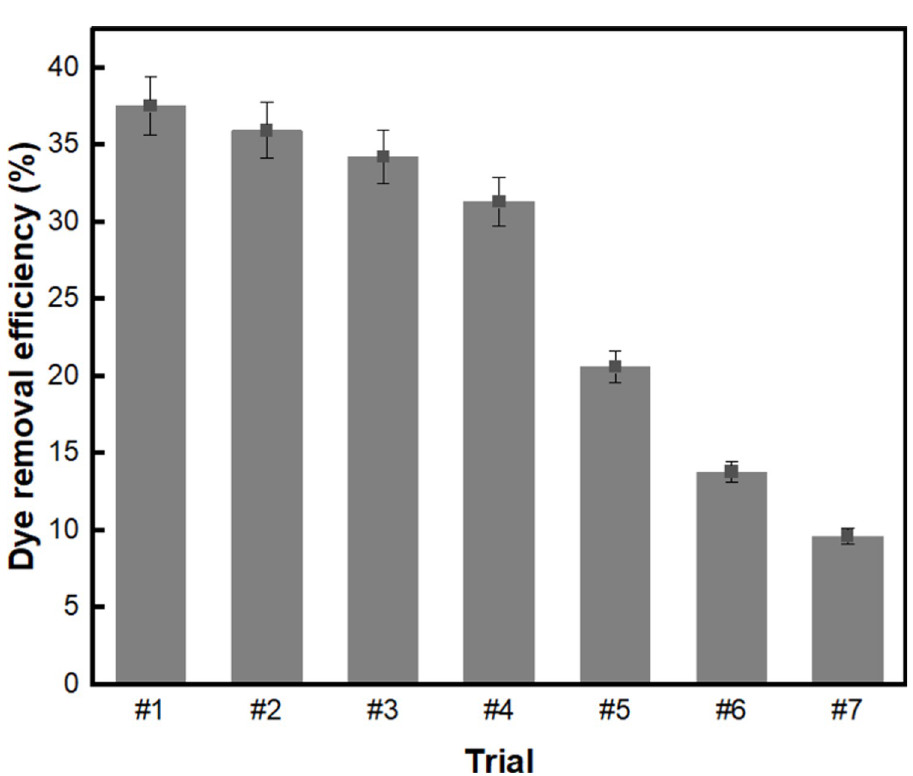
Fig 12. Dye adsorption rate (%) of BC-COF bio-leather with repeated dye adsorption trials (Extraction conditions: Liquor ratio of 1:10 (w/v), coffee at an amount of 200 wt% BC, 90˚C, 1 h; dyeing conditions: Fabric-to- liquor ratio of 1:10 (w/v), 70˚C, 30 min, meta-mordanting with 1% of FeSO 4 ; dye adsorption conditions: 50 mg/L of methylene blue solution with a fabric-to-liquor ratio of 1:200 (w/v), pH 6, 25˚C, 30 min).